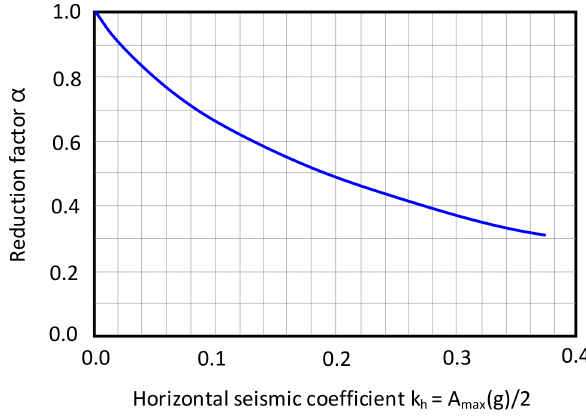
Figure 6. The relationship between reduction factor α and horizontal seismic coefficient k h . The calculation of F Sd ( ∆ u ) is shown as follows.